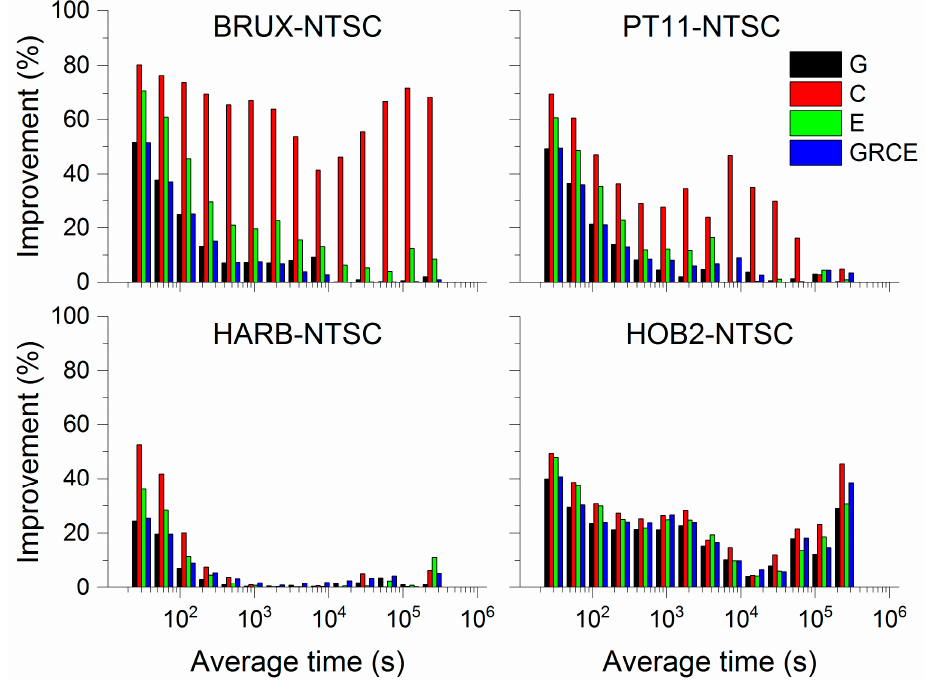
Figure 16. The improvement of scheme2 in stability, with respect to scheme1 on four time links with single-system and multi-GNSS models using COD products.